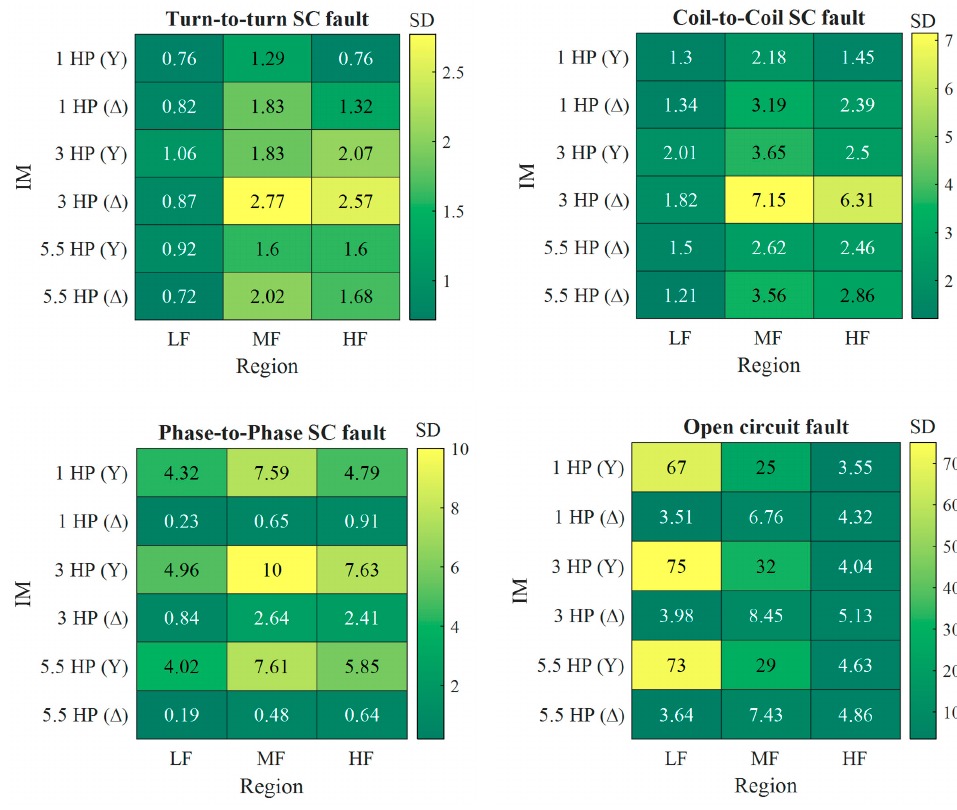
Figure 11. SD calculated values between normal and other faults.